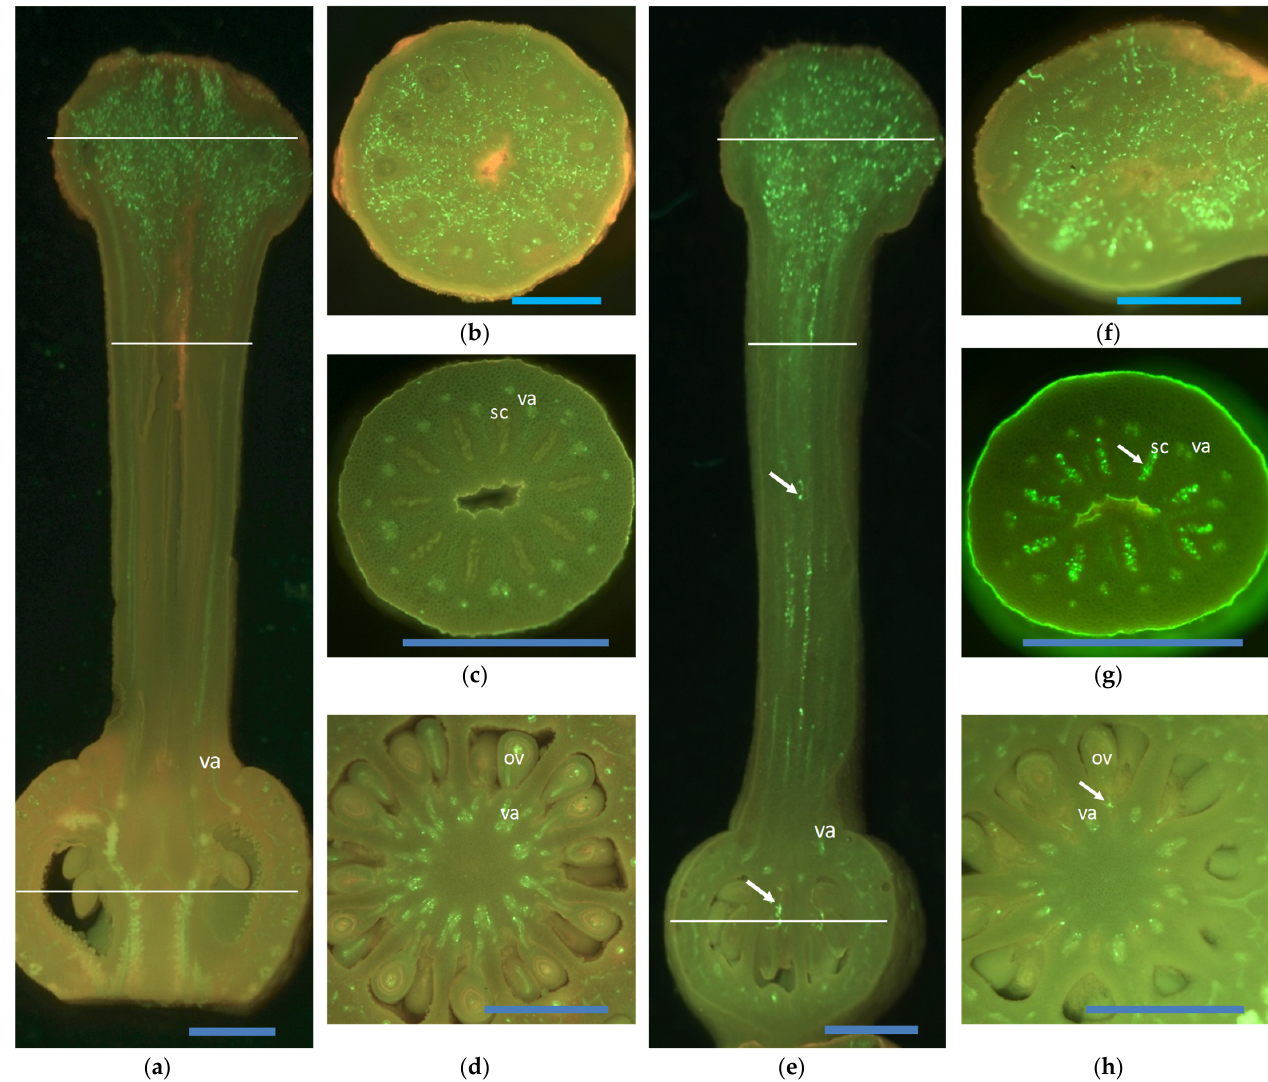
Figure 1. Histological sections of self-pollinated pistils. ( a – d ) Self-incompatible pistil 10 days after self-pollination. ( a ) Longitudinal section of the entire pistil in which high quantity pollen tubes were observed thorough the stigma whose growth further stopped in the upper style. ( e – h ) Self-compatible pistil 10 days after self-pollination. ( e ) Longitudinal section of the entire pistil in which high quantity pollen tubes were observed throughout the stigma, along the entire style and reached ovaries. The white lines on the longitudinal pistil sections indicate the transversal section that corresponds to the middle stigma ( b , f ), upper style ( c , g ), and ovary ( d , h ). Pollen tubes are marked by an arrow; va: vascular axis; sc: stylar canal; ov: ovule. Scale bars are depicted by blue lines: ( a , e ) 1 mm; ( b – g ) 0.5 mm. Pictures of ‘Fortune’ mandarin and ‘Monreal’ clementine are shown as examples of self-incompatible and self-compatible varieties, respectively.